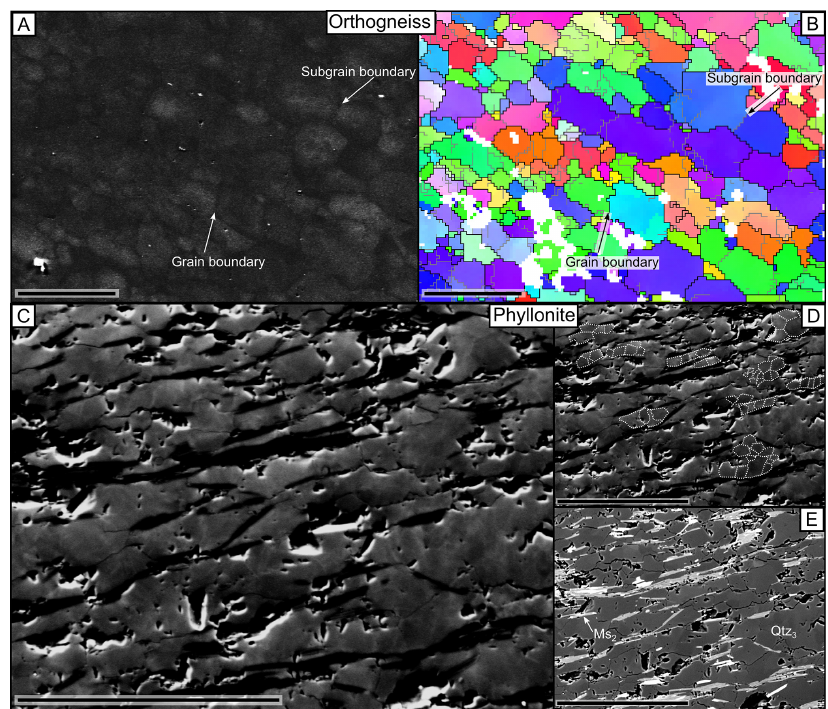
Figure 11. CL, EBSD and BSE images of quartz domains in orthogneiss and phyllonite B; scale bar is 100µm. (a) CL patterns from a Qtz 2 domain showing a structure consisting of lighter polygons surrounded by darker rims; (b) EBSD image of (a) showing the grain and subgrain boundary network; (c) CL pattern from a Qtz 3 –Ms 2 domain showing a structure dominated by thin intragranular bright lines or polygons, bordering or surrounding darker polygons; (d) area (c) with some of the polygonal structure traced; (e) BSE image of area (c) showing mineralogy and grain